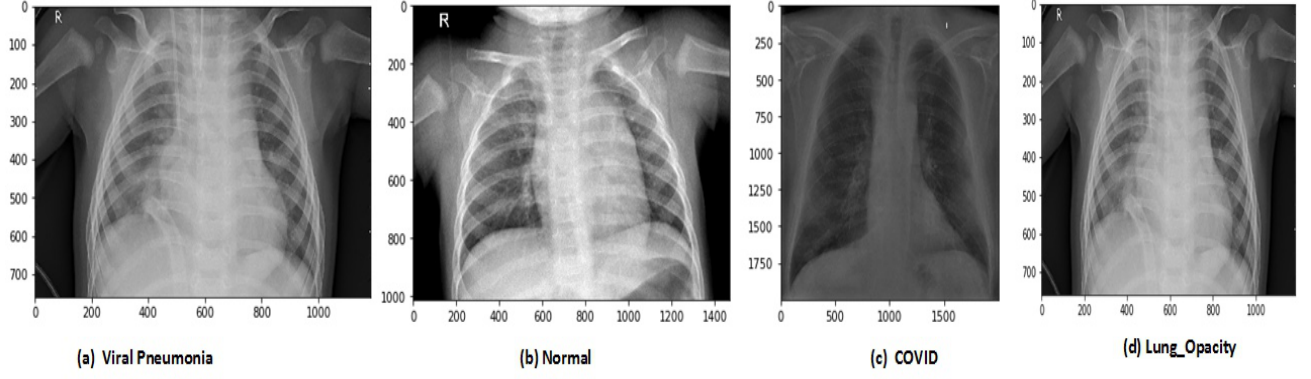
Figure 3. Types of chest X-ray images in CRD data set.